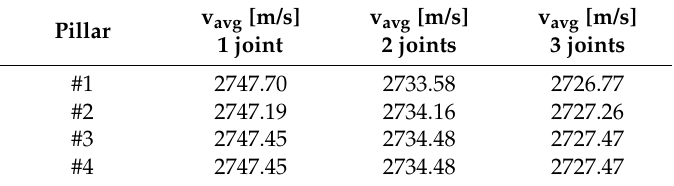
Table 4. The influence of the number of joints on the numerical wave propagation velocities. v avg [m/s] Pillar